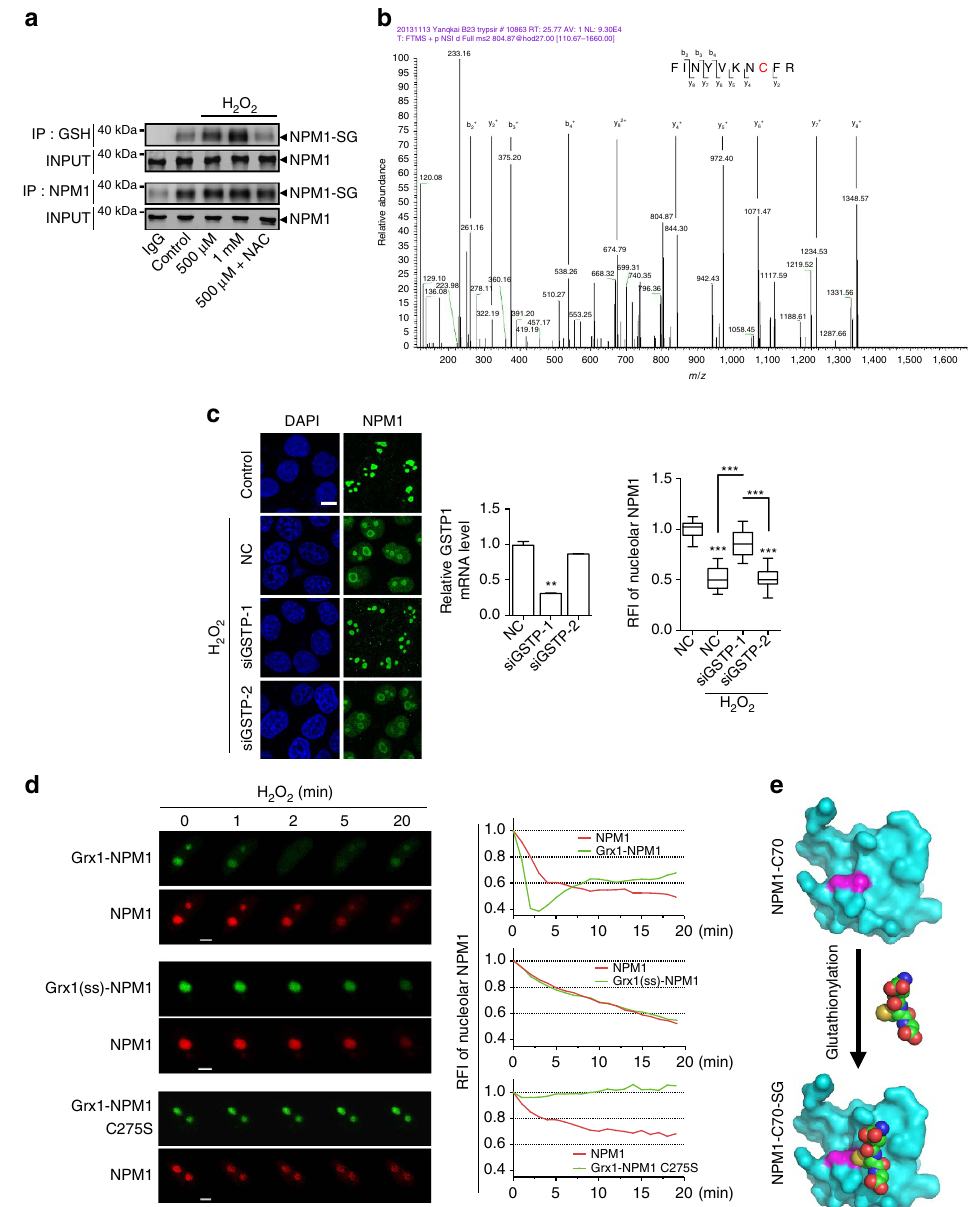
Figure 4 | NPM1 is S -glutathionylated at Cys 275 under stress. ( a ) Non-reduced co-IP assay. After gradient doses of H 2 O 2 (500 m M, 1mM) treatments ± antioxidant NAC (5mM) pretreatment, S -glutathionylated NPM1 in HeLa cells was co-immunoprecipitated and analysed with either anti-GSH or anti-NPM1 antibodies. ( b ) Tandem mass spectrometry (MS/MS) analysis of NPM1 protein derived from non-reduced co-IP. FLAG-NPM1 was transfected to HEK293Tcells exposed to H 2 O 2 (500 m M) and immunoprecipitated by anti-FLAG M2 gel. The amino acid sequence of peptides was reconstructed by analysis of the b (cid:2) ion or y (cid:2) ion series. The MS/MS spectrum of the m/z y 5 þ (972.4026) was corresponding to the NPM1 peptide KNCFR S -glutathionylated at Cys 275 , in comparison with the non-modified spectrum 667.3344 in Supplementary Fig. 4c. ( c ) NPM1 translocation (left) and RFI changes of nucleolar NPM1 (right, n ¼ 57 cells) after H 2 O 2 (500 m M) treatment in HeLa cells. GSTP were silenced with two siRNA oligo and the relative GSTP mRNA level were showed (middle, siGSTP-1 and siGSTP-2). Unpaired t -test, ** P o 0.01 or *** P o 0.001. ( d ) Translocation of EGFP-NPM1 WTand C275S mutant fused with active or inactive Grx1 at N-terminal upon H 2 O 2 (500 m M) exposure. ( e ) The surface representation of NPM1 binding interface was based on NPM1-C70 structure (PDB 2vxd ) with Cys 275 coloured in magenta. GSH molecule, shown in sphere with nitrogen atom in blue, oxygen in red and carbon atom in green, could covalently link to Cys 275 through thiol exchange. Scale bars, 10 m m ( c ) and 5 m m ( d ). Data were represented as mean ± s.e.m. Grx1(ss), inactive Grx1. NPM1-SG, S -glutathionylated NPM1. NPM1-C70, C-terminal of NPM1 (70 amino